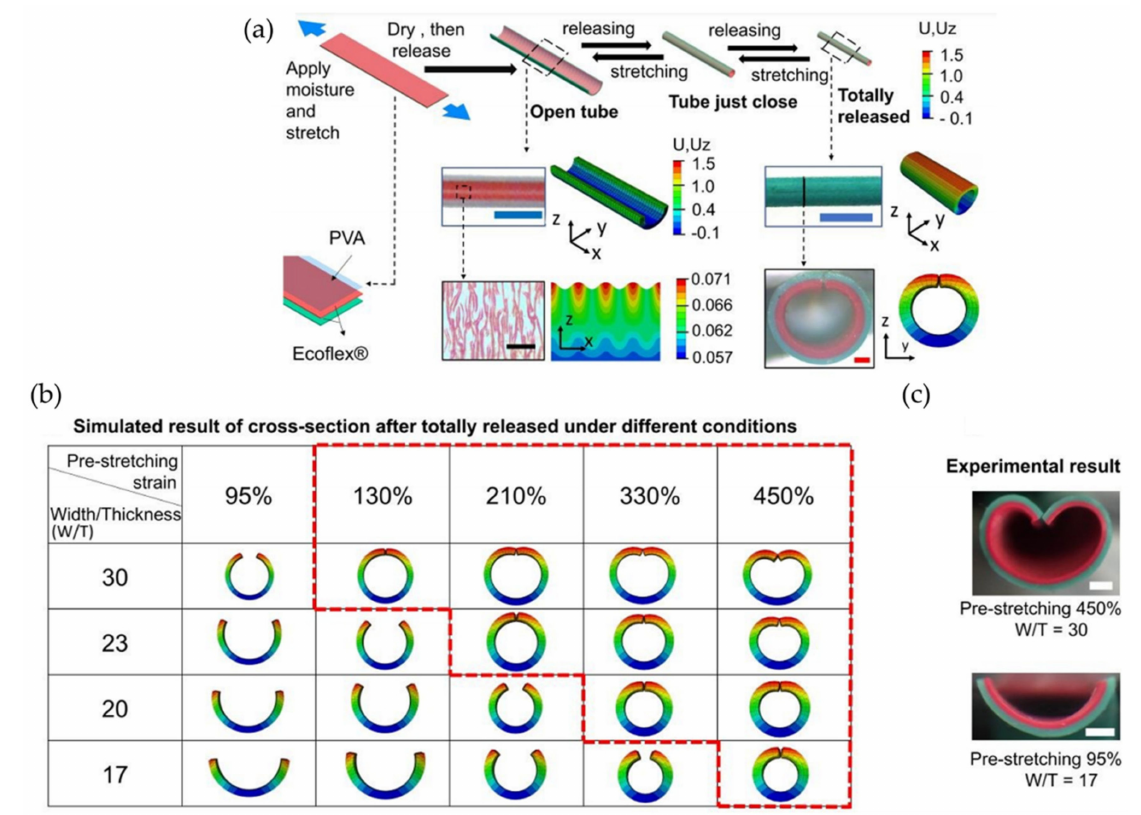
Figure 29. ( a ) Schematic representation of the PVA-Ecoflex ® tubular geometry fabrication, ( b ) sim- ulated result, and ( c ) experimental result of the tube cross-section after released under different width/thickness ratios and pre-stretching strains. Reproduced with permission from reference